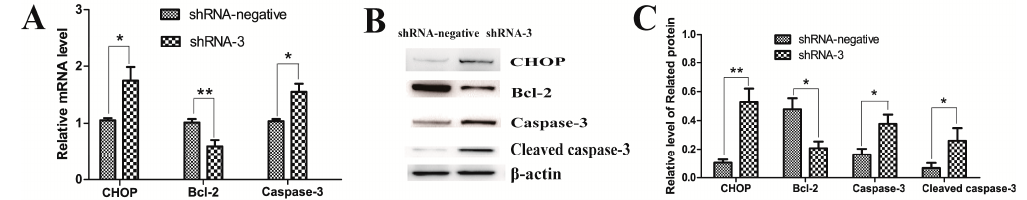
Figure 3. Effect of XBP1 knockdown on cell apoptosis. ( A ) Relative mRNA levels of genes (CHOP, Bcl-2, and caspase-3) are detected by real-time PCR in mouse GCs in the shRNA-3 and shRNA-negative groups; ( B , C ) Relative protein levels of genes (CHOP, Bcl-2, caspase-3, and cleaved caspase-3) are detected by western blot in mouse GCs in the shRNA-3 and shRNA-negative groups. The analyses of the band intensity are presented as the relative ratio of objective protein to β -actin. Data are shown as the mean ± SEM. Bars with asterisks represent a significant difference (* p < 0.05, ** p <